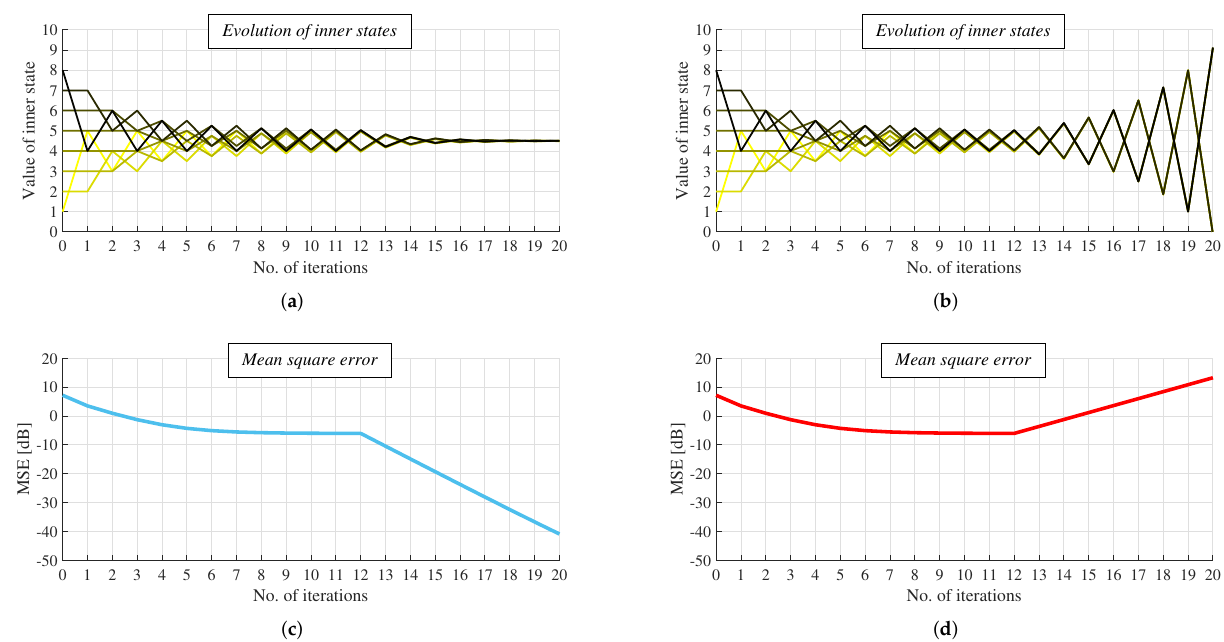
Figure 13. Comparison of evolution of inner states and MSE in bipartite regular connected and non-bipartite non-regular connected graph formed by eight vertices; provided mixing parameter is reconfigured during algorithm execution − example. ( a ) Evolution of inner states in bipartite regular connected graph, mixing parameter reconfigured to value lower than 1/ ∆ . ( b ) Evolution of inner states in non-bipartite non-regular connected graph, mixing parameter reconfigured to value greater than 1/ ∆ . ( c ) Evolution of MSE in bipartite regular connected graph, mixing parameter reconfigured to value lower than 1/ ∆ . ( d ) Evolution of MSE in non-bipartite non-regular connected graph, mixing parameter reconfigured to value greater than 1/ ∆